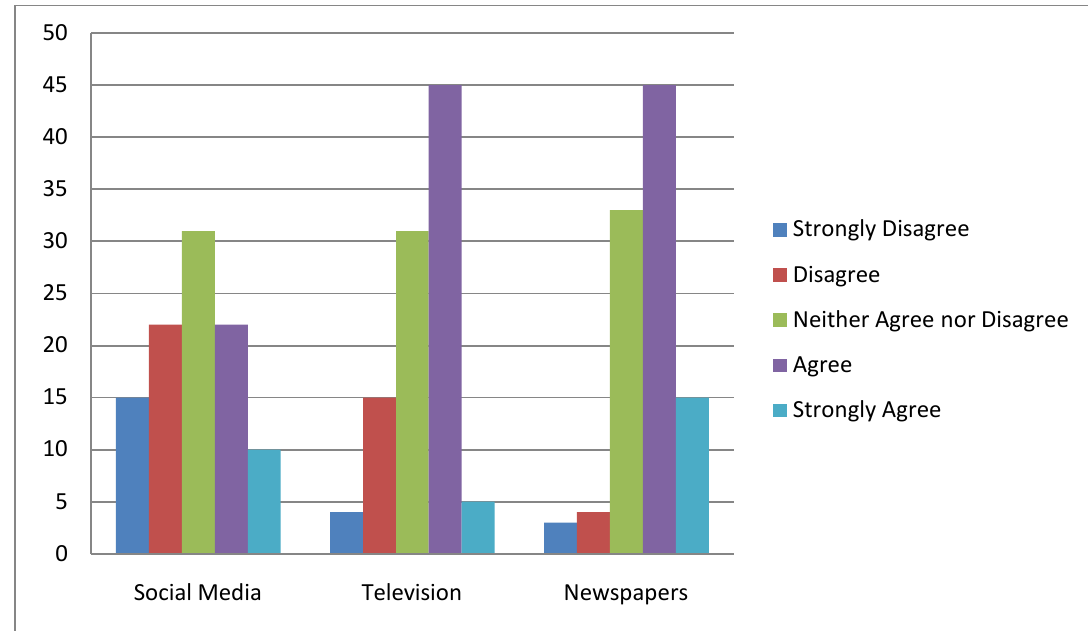
Graphic 4: Authenticity of Media for Promotion of Scientific Approaches (Source: Online